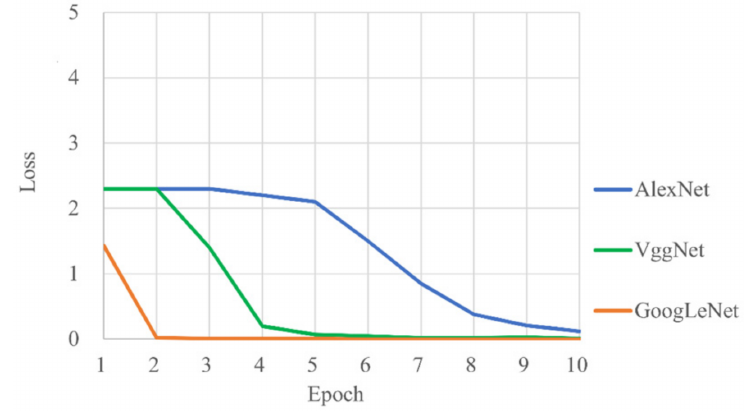
Figure 16. Loss–epoch curve of three CNN models. Table 1. Parameters of three CNN models’ training.